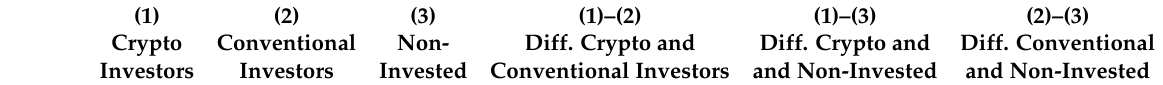
Table 4. Monthly means of consumption categories and t -tests of crypto owners, conventional and non-investors. Source: Own